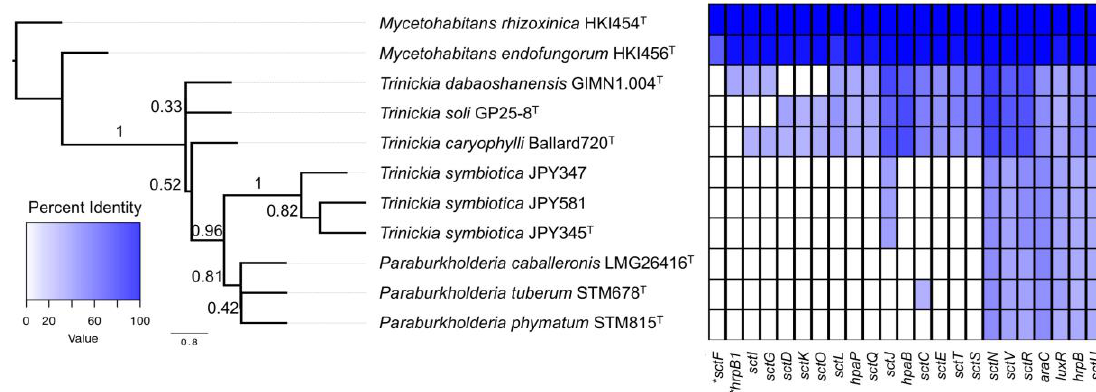
Figure 4. The type III secretion system genes in Mycetohabitans, Paraburkholderia , and Trinickia strains. The columns of the heatmap correspond to the percentage identity of protein sequences of type III secretion system genes in M. rhizoxinica HKI454 T . At left is the unrooted consensus tree indicated by 21 gene trees with a final quartet score of 0.799. Displayed at the branch points are the support values for the quadripartition as determined by Astral-II. *The gene sctF , found in only 2 genomes, was not used to build the tree; hrpB1 , only found in 3 genomes, was also excluded.